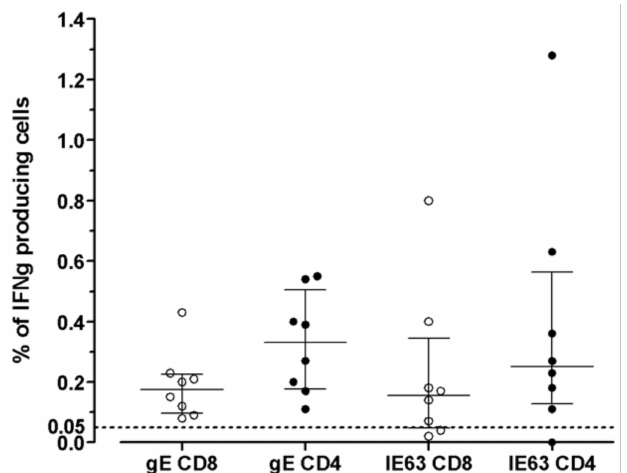
Figure 3. VZV-specific T-cell response to gE and IE63 in 8 VZV-seropositive healthy subjects measured by ICS assay. Results are shown as the percentage of production of IFN γ (cut-off